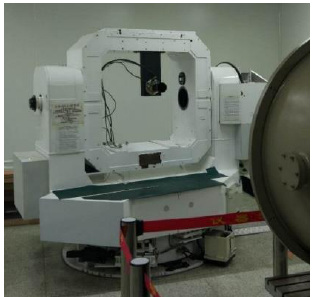
Figure 9. Experimental platform of star sensor.